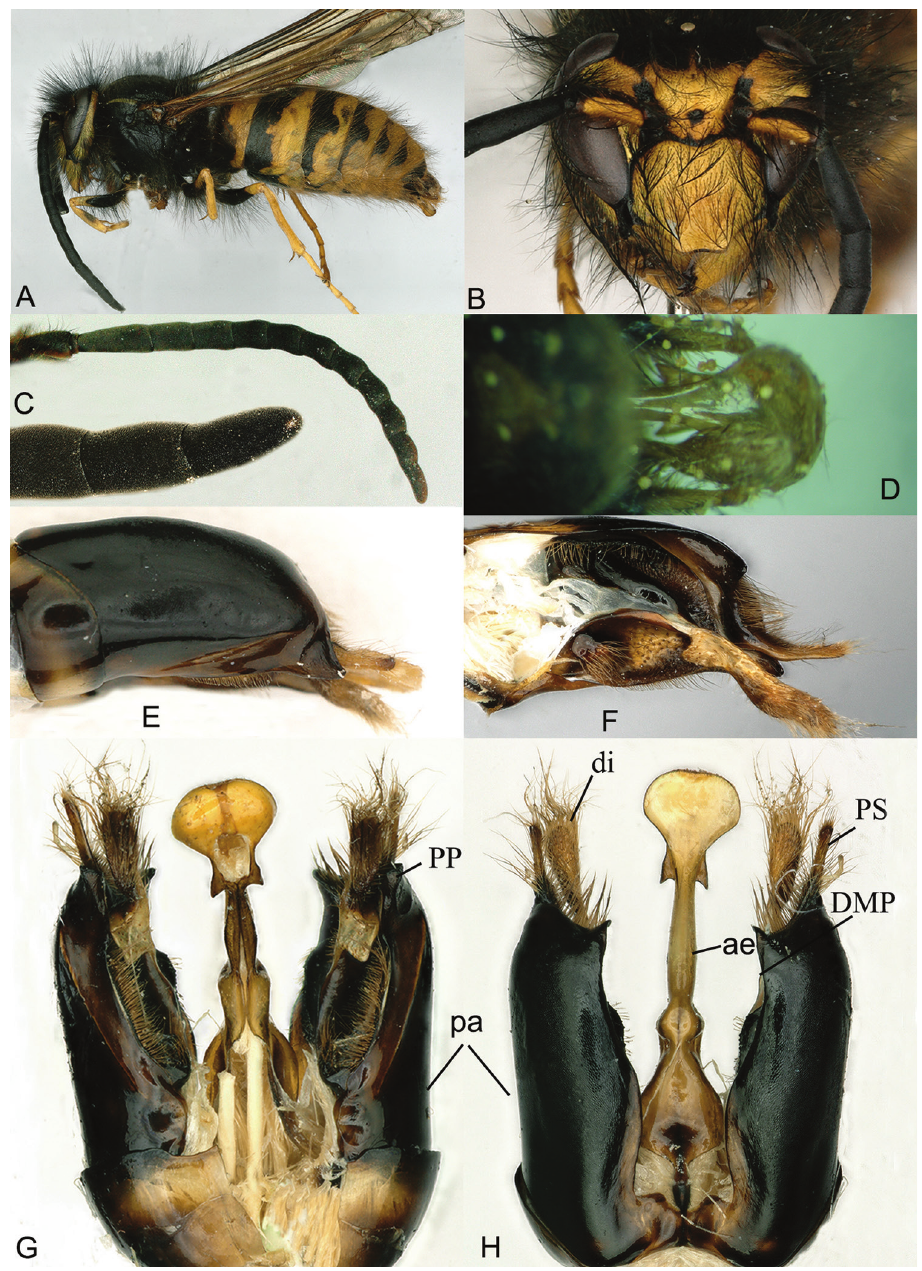
Figure 5. Vespula structor (Smith), male ( ♂ ). A Body, lateral view B habitus, anterior view C right antenna and terminal seven segments of antenna D metasomal apex of paratype of Vespula gongshanensis (from Yunnan), showing part of aedeagus E genitalia, lateral view F paramere, inner view G genitalia, ven- tral view H ibid, dorsal view. Abbreviations: ae, aedeagus; di, digitus; pa, paramere; DMP, dorsal margin of paramere; PP, parameral process; PS, parameral